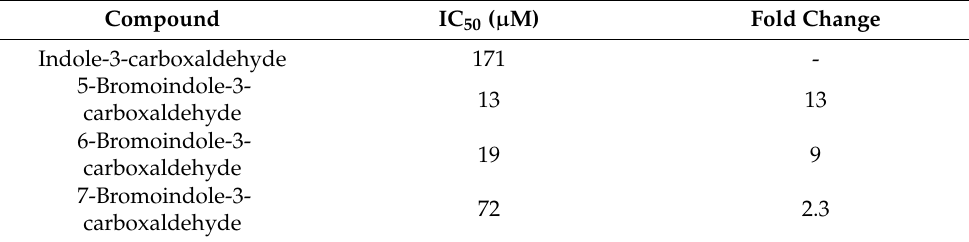
Figure 2. Absorbance at OD 595 for varying concentrations of brominated indole carboxaldehydes. For all compounds, absorbance decreased with increasing concentration. ( A ) Indole-3-carboxaldehyde, ( B ) 5-Bromoindole-3-carboxaldehyde, ( C ) 6-Bromoindole-3-carboxaldehyde, ( D ) 7-Bromoindole-3-carboxaldehyde. Table 2. Average IC 50 values of brominated indole carboxaldehydes and fold reduction in IC 50 from the control. The control, indole-3-carboxaldehyde, had the highest IC 50 value. Test compound 5-bromindole-3-carboxaldehyde had the lowest IC 50 value and the greatest reduction from the control. Test compound 7-bromoindole-3-carboxaldehyde had the highest IC 50 value and the smallest reduction from the